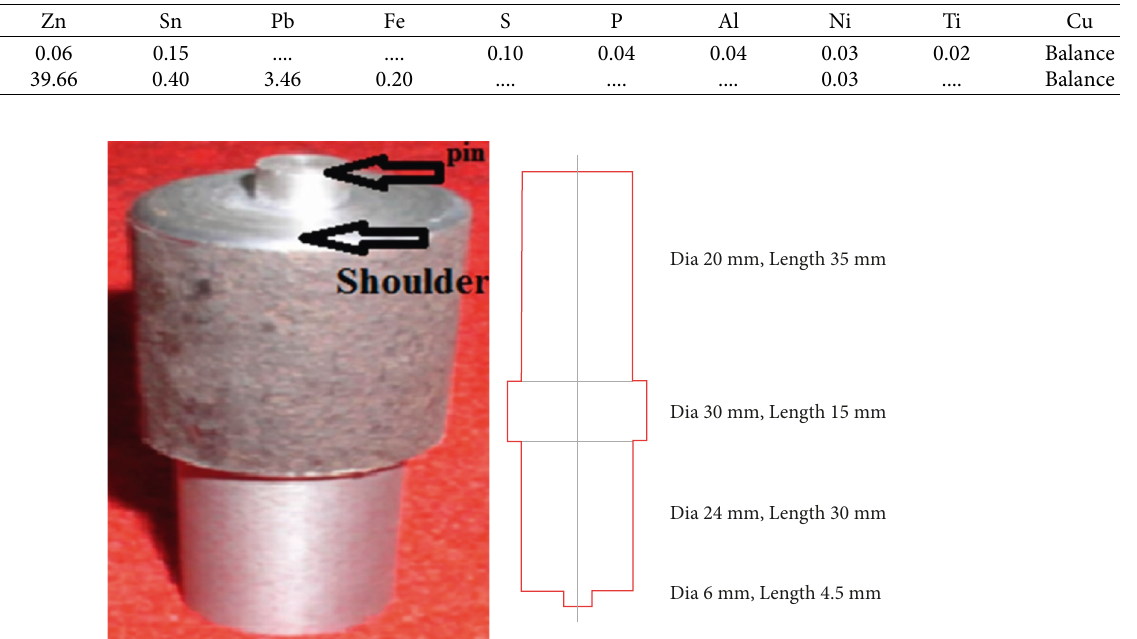
Table 2: Cu and Br materials exhibit different chemical compositions.